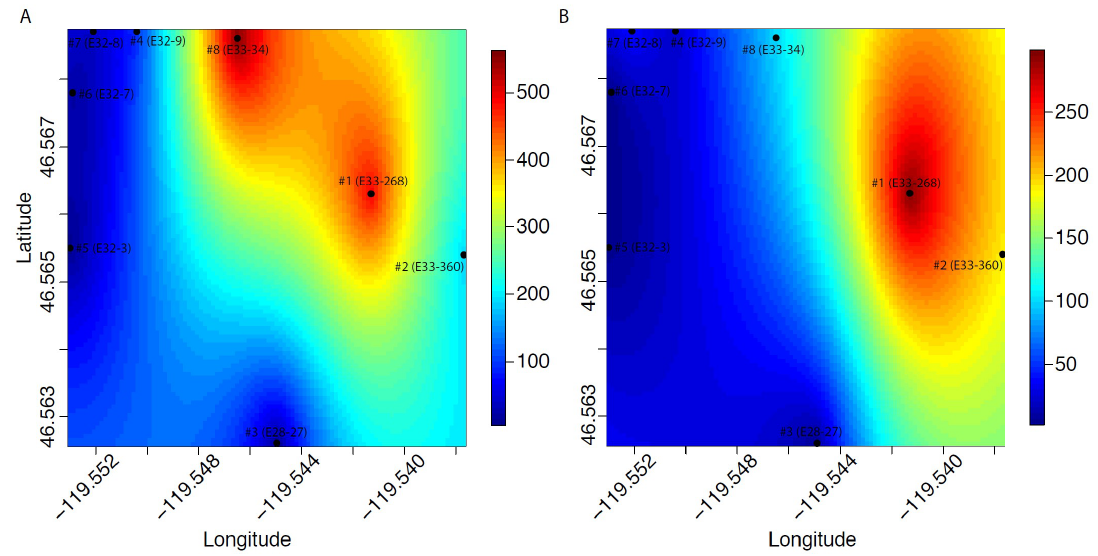
Figure 1. Historical maximum ( A ) and recent ( B ) [CN − ] values in spatial relation to the wells examined for this study, as interpolated by kriging.